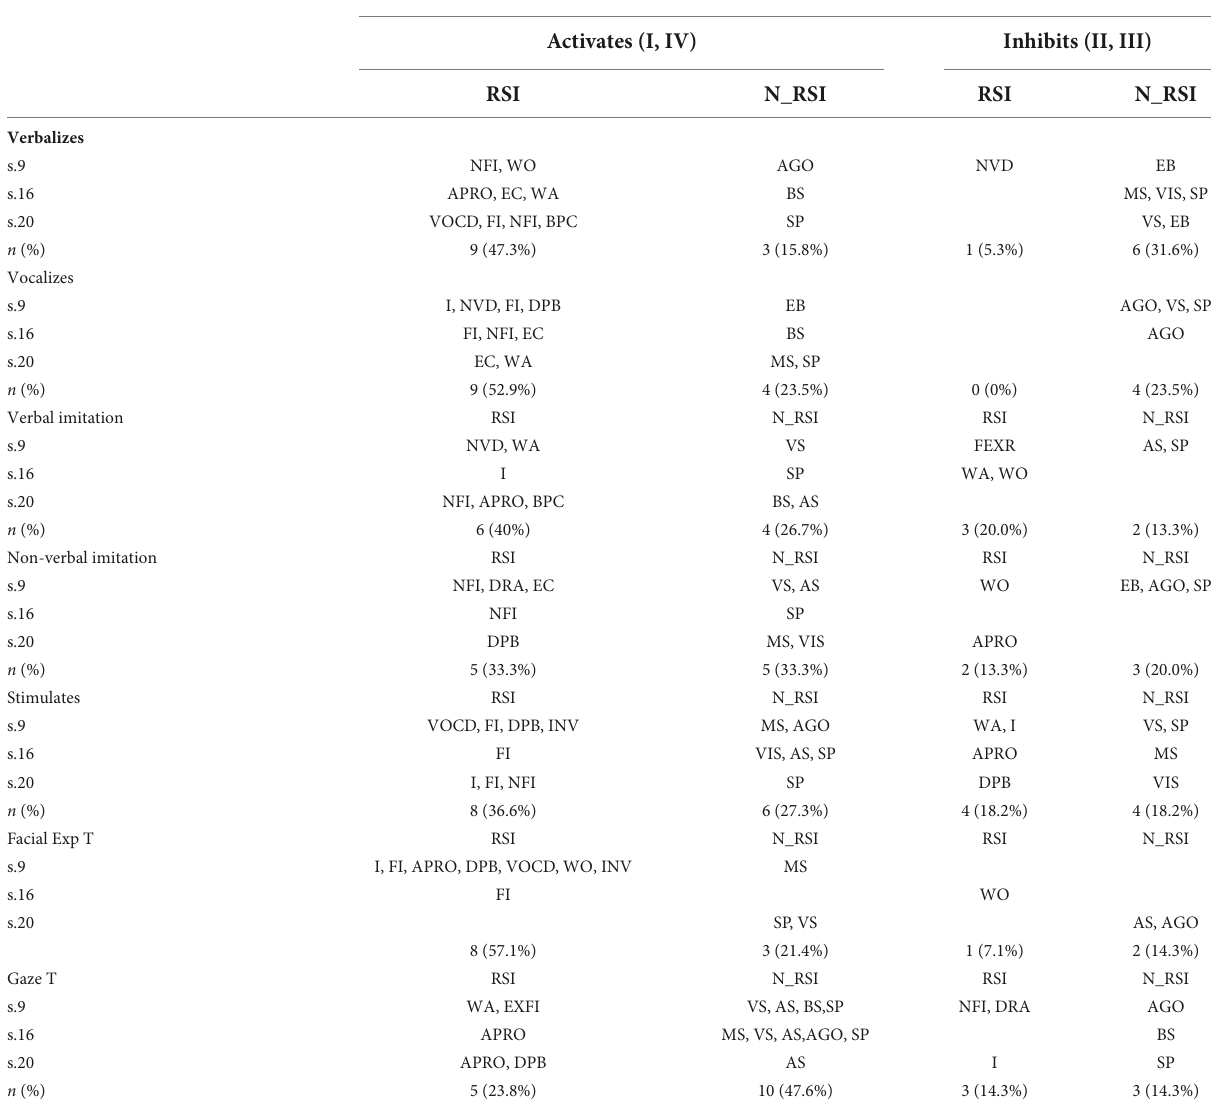
TABLE 4 Type and percentage of behaviors that prospectively activated or inhibited each of the therapist’s dimensions. Behavior criterion (therapist) Conditioned behavior